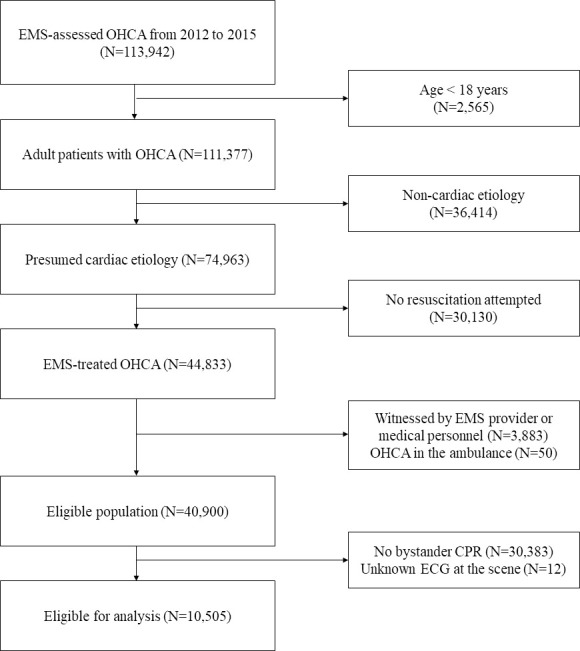
Flowchart of study inclusion.Abbreviations: OHCA, out-of-hospital cardiac arrest; EMS, emergency medical service; CPR, cardiopulmonary resuscitation; ECG, electrocardiogram.